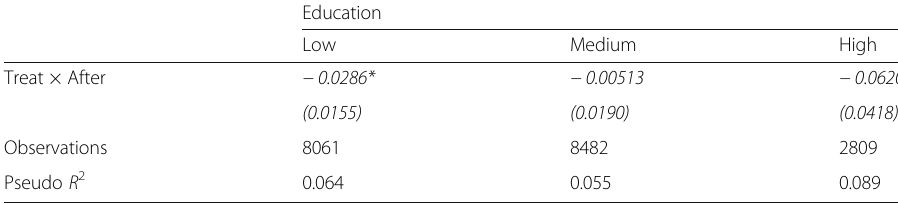
Table 7 Effect of AUH on the probability of entering the labor force. Heterogeneities: woman ’ s education Education Low Medium High Treat × After − 0.0286*